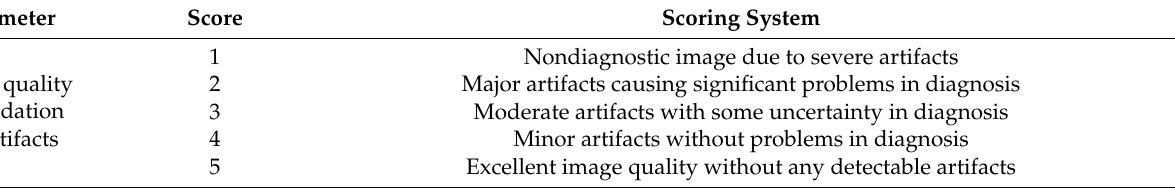
Table 1. Details of scoring scale in the assessment for various parameters.